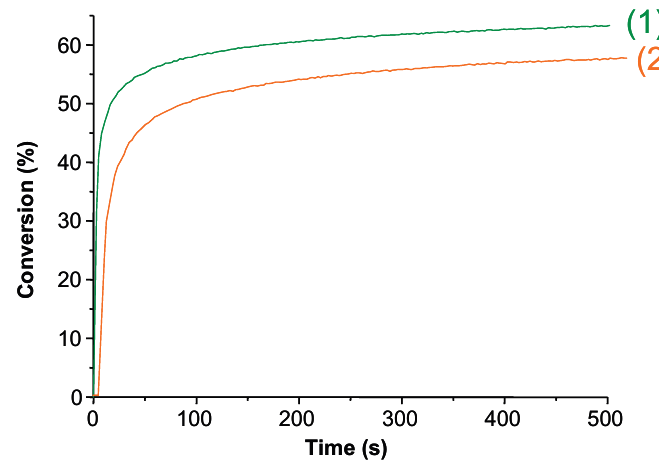
Figure 4. Photopolymerization profiles of TMPTA in the presence of G 1 /iodonium salt/NVK (0.2%/2%/3%, w/w/w) upon the LED at 405 nm (curve 1) or LED at 455 nm (curve 2) exposure in